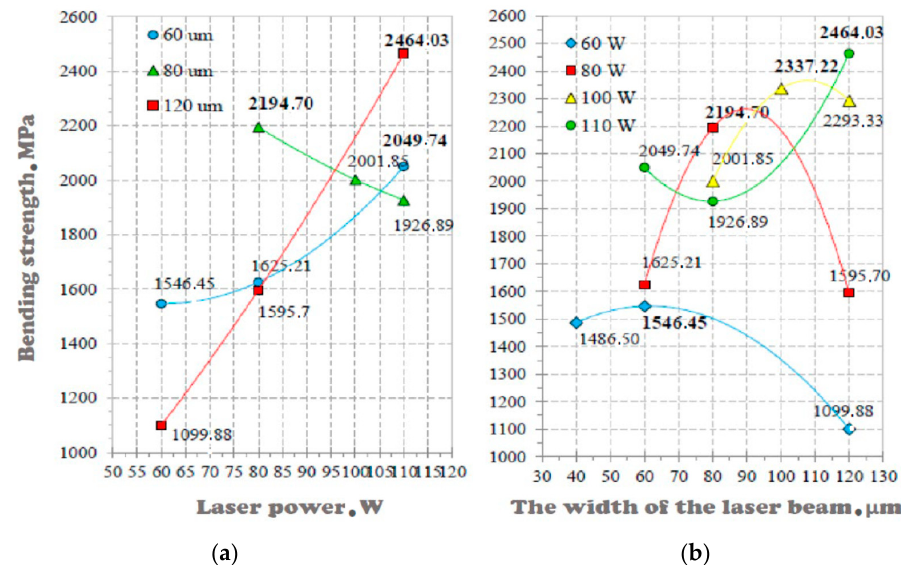
Figure 10. Relationship of bending strength ( a ) on the laser power for different widths of the laser beam ( b ) on the width of the laser beam for different values of the laser. 1.